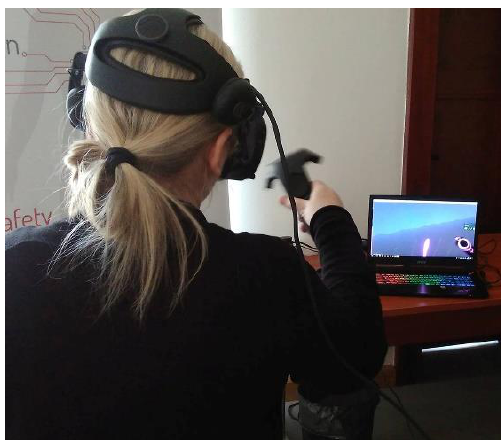
Figure 5. A university lecturer is shown the capabilities of an eye tracker and its software in the VR environment (photo from studies in 2018).